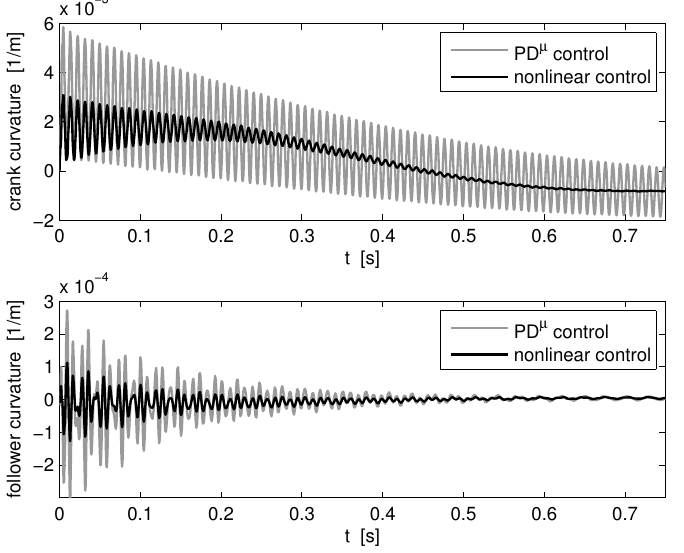
Figure 7. Curvature of the crank and follower, detail, comparison with PD µ controller.